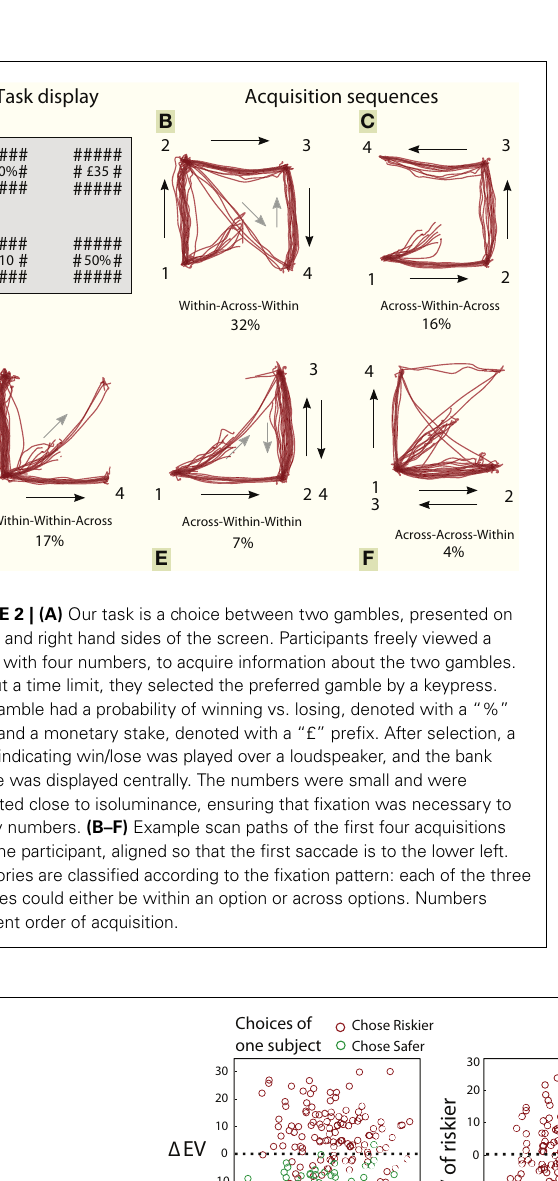
difference), on others it was hard (large EV difference). Colors demonstrate the choice on each trial for one representative participant, showing near-optimal